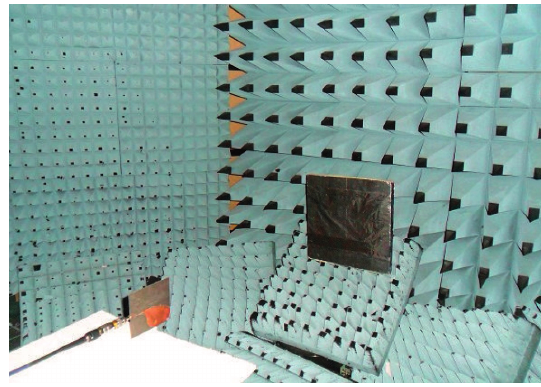
Figure 4. Photo of the setup considered for the software stress test.